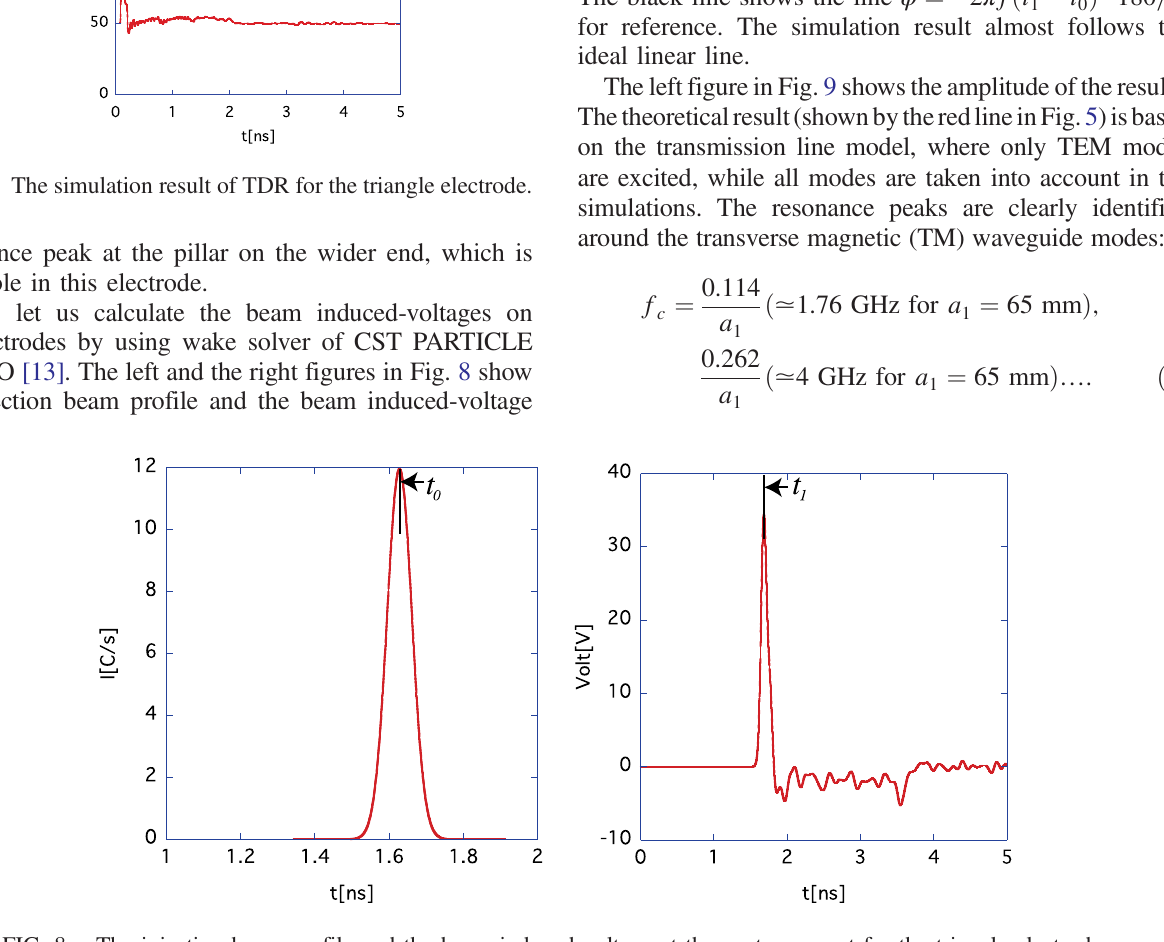
FIG. 8. The injection beam profile and the beam-induced voltage at the upstream port for the triangle electrode.